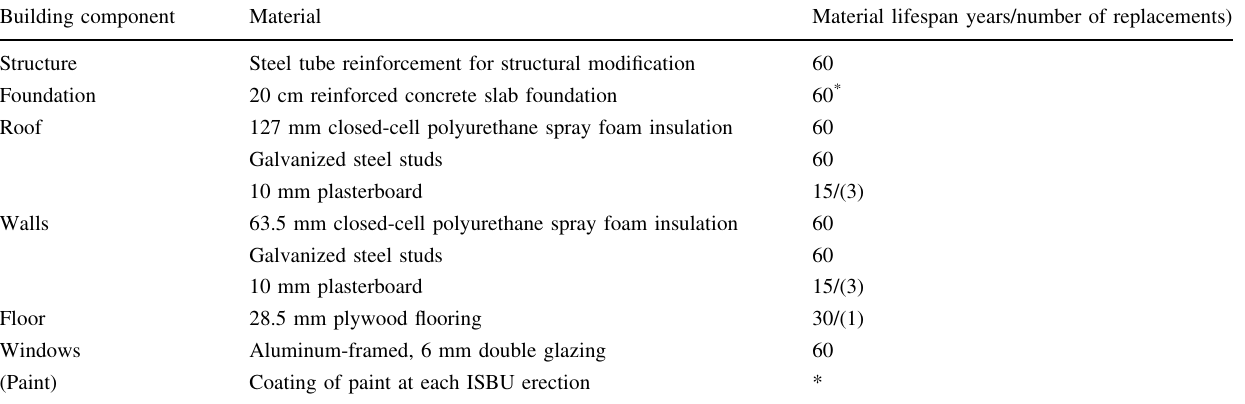
Table 1 Material use and maintenance requirements of temporary intermodal steel building units Building